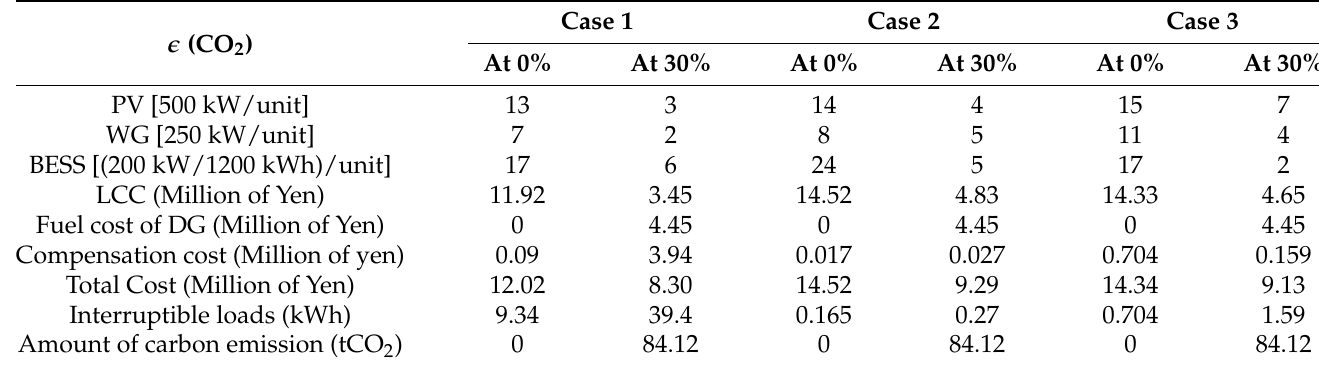
Table 3. Simulation results of each case.